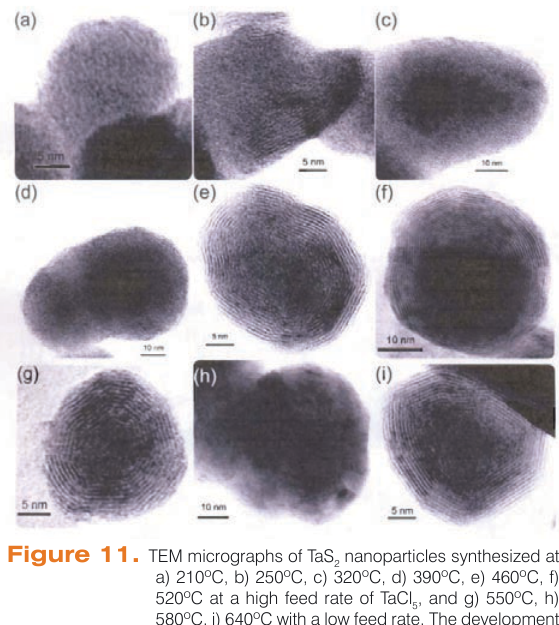
Figure 11. TEM micrographs of TaS nanoparticles synthesized at 2 a) 210ºC, b) 250ºC, c) 320ºC, d) 390ºC, e) 460ºC, f) 520ºC at a high feed rate of TaCl , and g) 550ºC, h) 5 580ºC, i) 640ºC with a low feed rate. The development of an IF structure with ever-improving crystallinity with rising temperature is revealed. Furthermore, the nano- particles become more faceted and an amorphous core can be recognized (adapted from Ref.